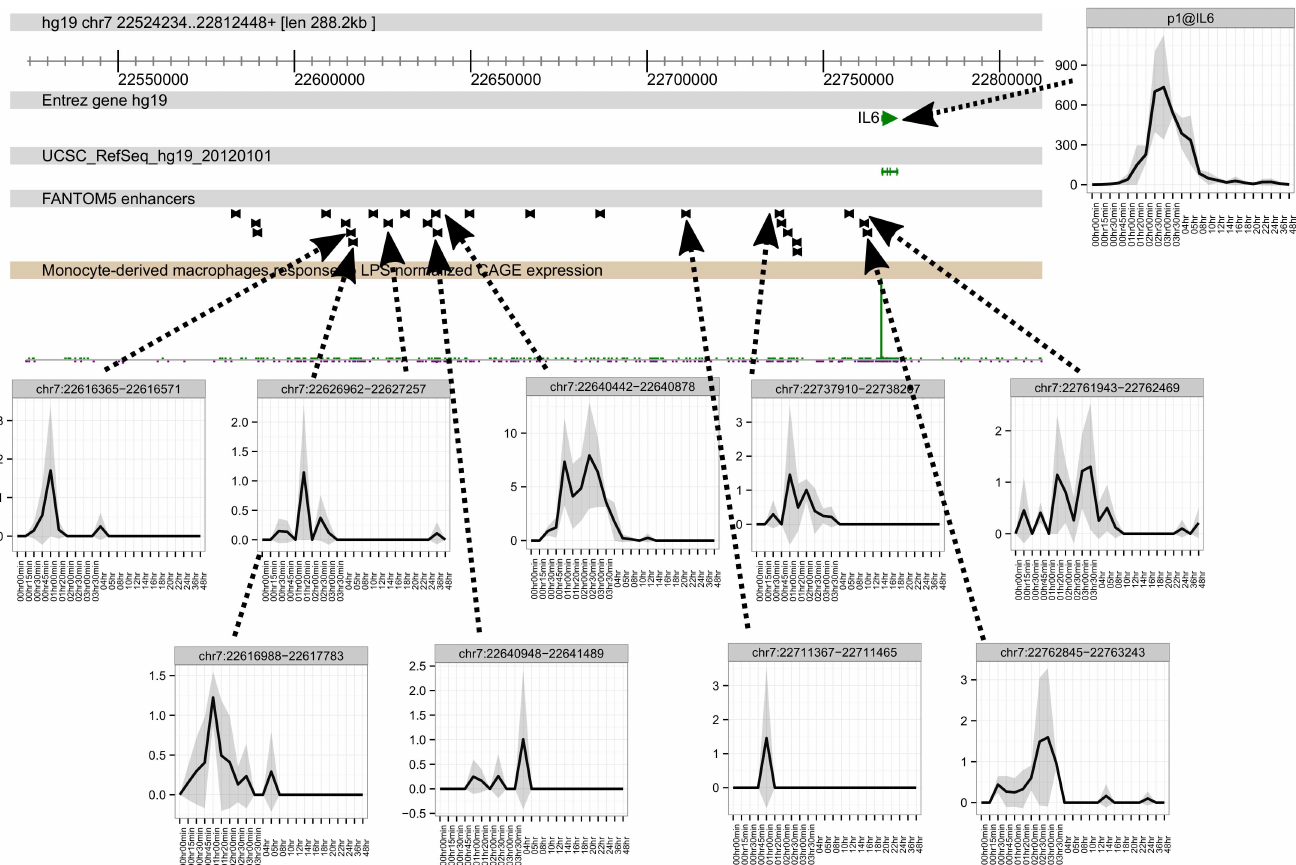
Fig 3. The time course of activation of enhancers and promoter at the IL6 locus. The core panel shows a genomebrowser view of the IL6 locus with the locationsof FANTOM5 enhancers. The upper right panel shows the time course of inductionof IL6 mRNA, detected by CAGE, which peaks around3–4 hours and declinesby 12 hours. The lower panels show the transient activity of the enhancers indicated, the majority of which peak around 1–2 hours and declinerapidly. Data are expressedat TPM, and are the averageof the three